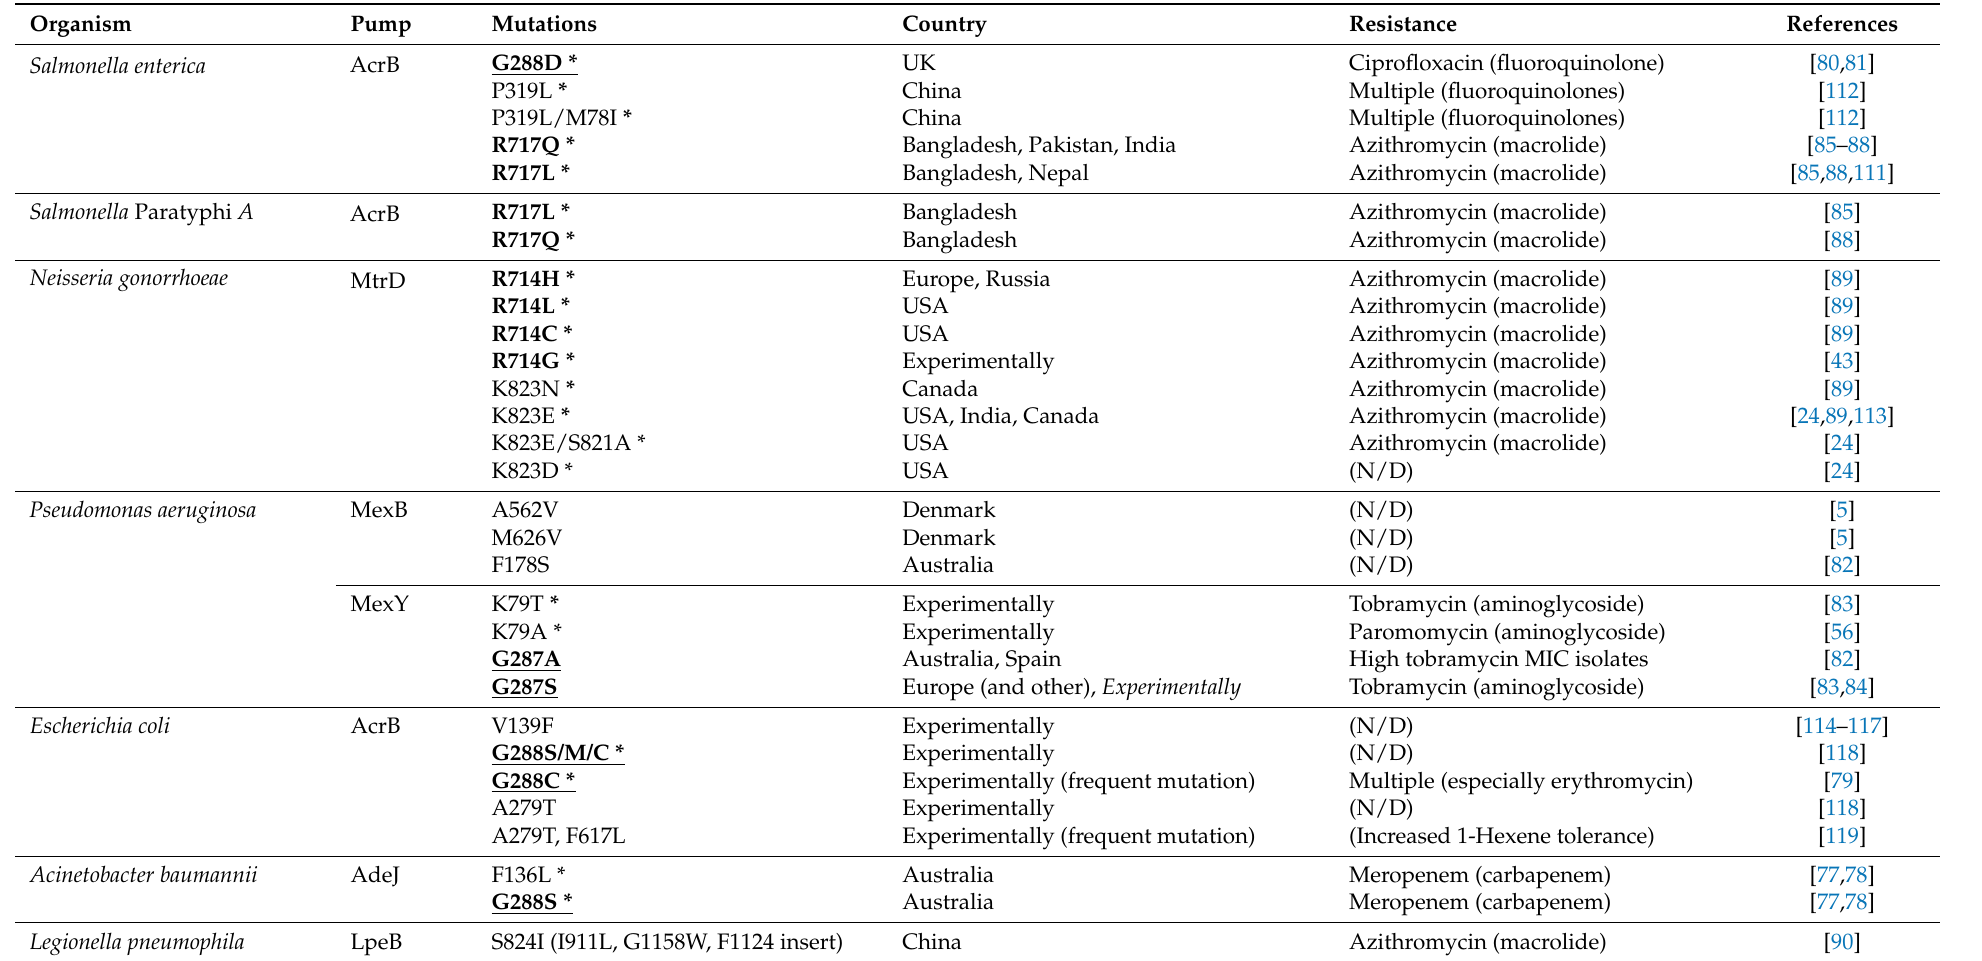
Table 9. RND mutations in recent clinically, environmentally and experimentally evolved